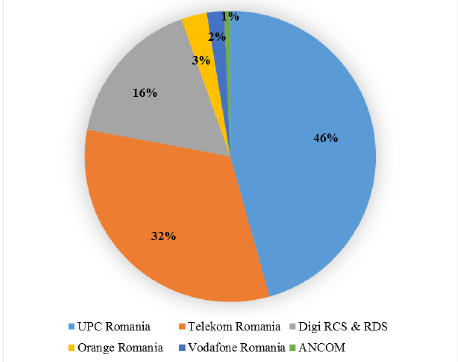
Figure 9. Provider wireless networks Table 7. Provider wireless networks percentage